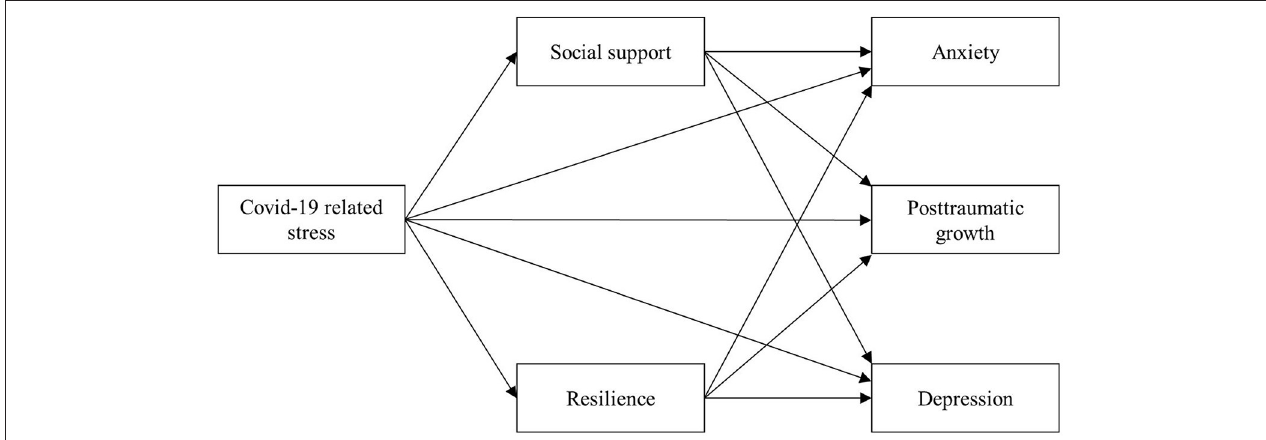
FIGURE 2 | Hypothesized conceptual framework indicating the relationships among the COVID-19 related stress, social support, resilience, and mental health outcomes (depression, anxiety, and posttraumatic